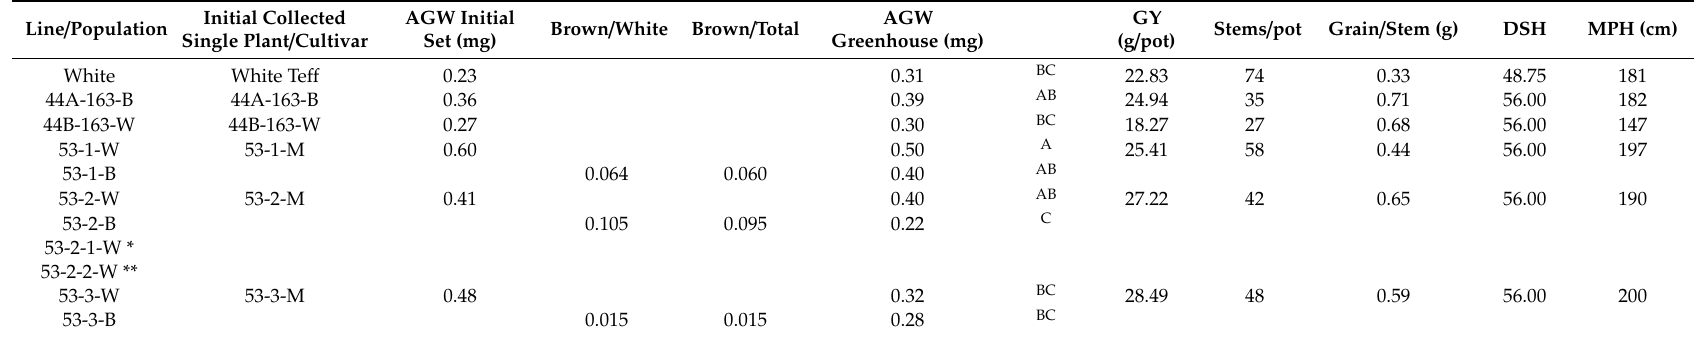
Table 1. List populations, average grain weight (AGW) of the initial seed set, seed color (W for white and B for brown). The phenotype of plant that grew in the greenhouse includes: AGW (mg), grain yield (g / pot), stems per pot, grain per stem (g), days from sawing to panicle emergence (DSP in days), maximal plant height (MPH in cm), and the proportion of brown out of white seeds, and out of total, quantified in grams. Initial Collected AGW Initial AGW GY Line / Population Brown / White Brown / Total Stems / pot Grain / Stem (g) MPH (cm) Single Plant / Cultivar Set (mg) Greenhouse (mg) (g / pot) White White Te ff